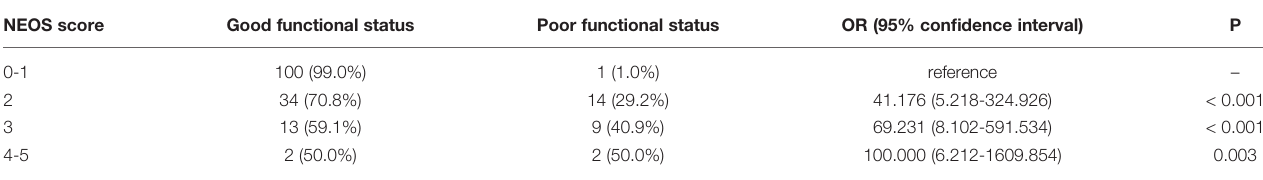
TABLE 3 | Risks for poor functional outcome in patients with different NEOS scores. NEOS score